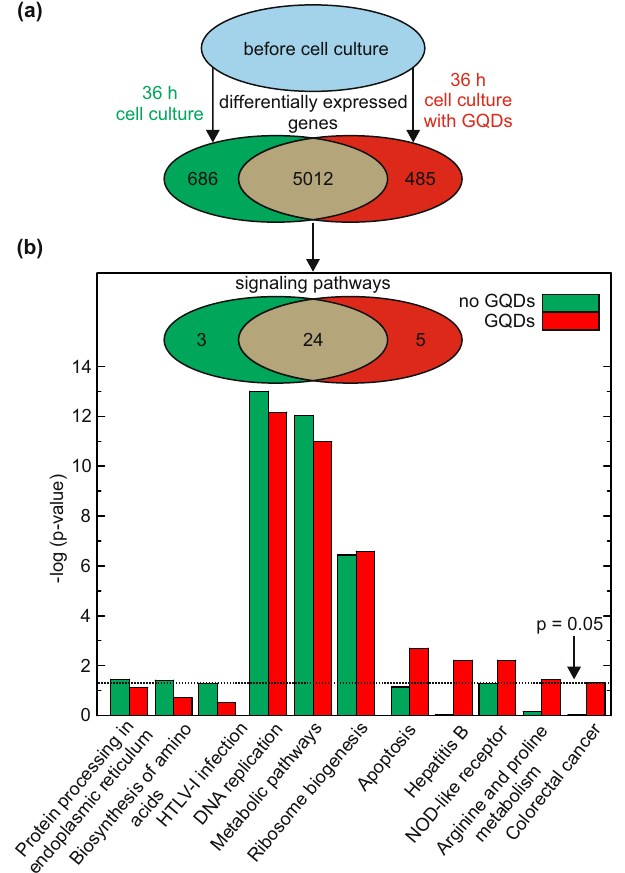
Figure 5. Sketch of the design and the result of the gene expression experiment. The transcriptome of the CD34 + cells was measured before and after exposure of the cells to the two experimental conditions. The modified gene expressions are sorted according to the ratio of their amplification in the presence vs. the absence of the GQDs in the culture. The expression of 5012 genes was changed under both culture conditions, while the expression of 485 genes was only changed in the presence of GQDs and the expression of 686 genes only differed when the CD34 + cells were cultivated without GQDs. ( b ) Allocation of the changes to 24, 5 and 3 affected signaling pathways, respectively (inset) and the -log p - values of the 8 pathways with significant response to the GQDs (main figure). Also shown is the effect on the pathways DNA replication, metabolic and ribosome